Question: Summarize what this figure shows in one sentence.
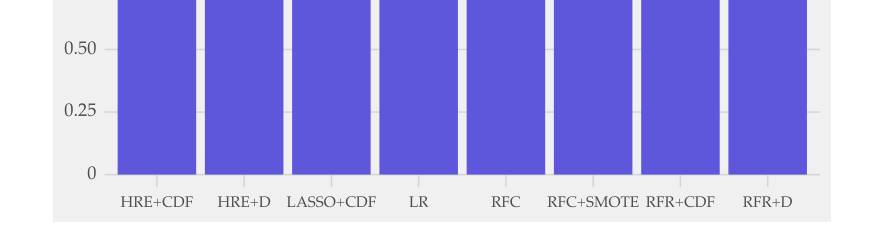
Answer: Results from the Bayesian correlated t-test. Probability of NN+CDF losing, drawing, or winning significantly against the respective method when considering a ROPE of 1%.